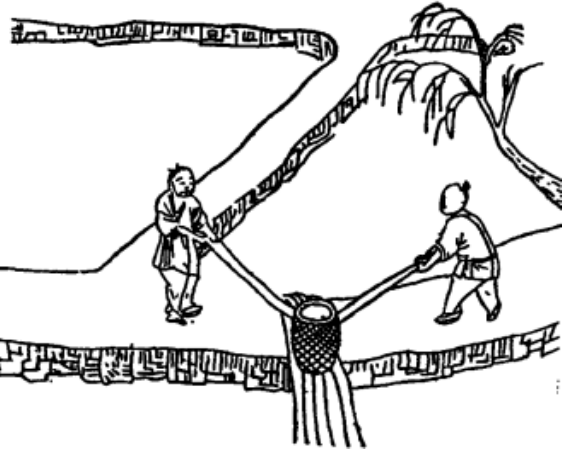
Figure 6. Schematic illustration of water lifting scenario with the Hùd ǒ u [40].